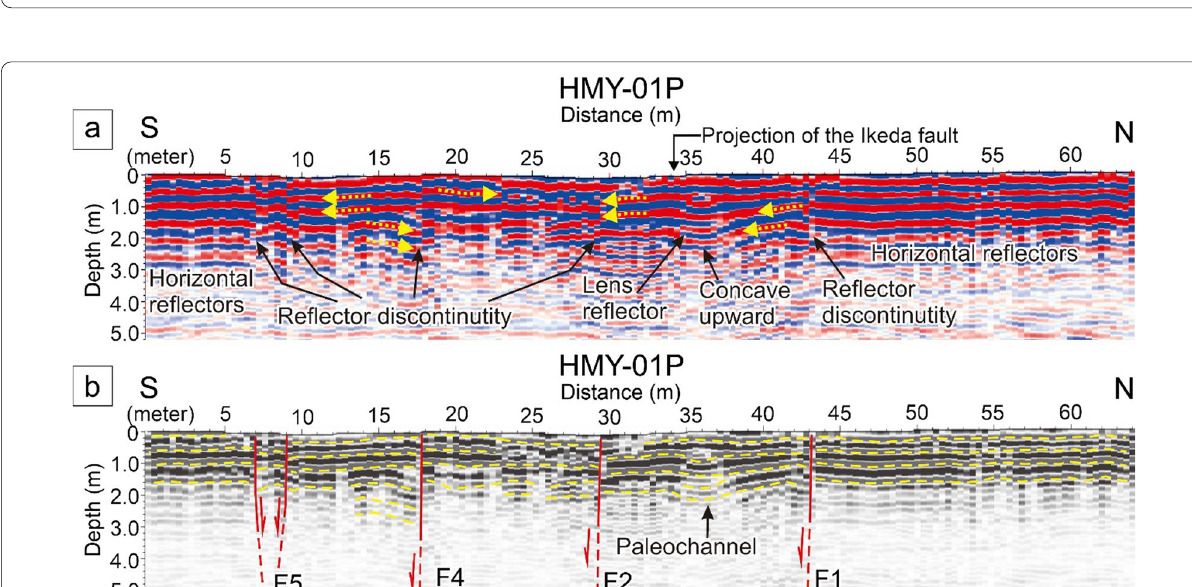
Fig. 5 a Processed GPR section of the HMY-01P. b Interpretation of the HMY-01P. Four faults are identified based on the displaced reflectors. The dashed yellow line indicates the trace of reflectors. The yellow dotted arrow indicates the dip of